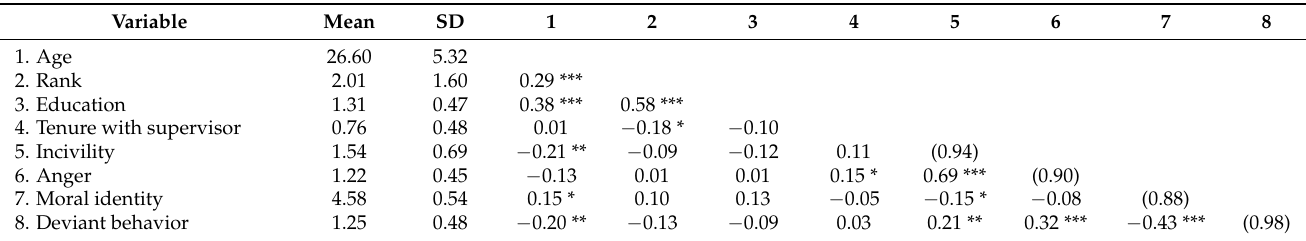
Table 3. Means, standard deviations, correlations, and